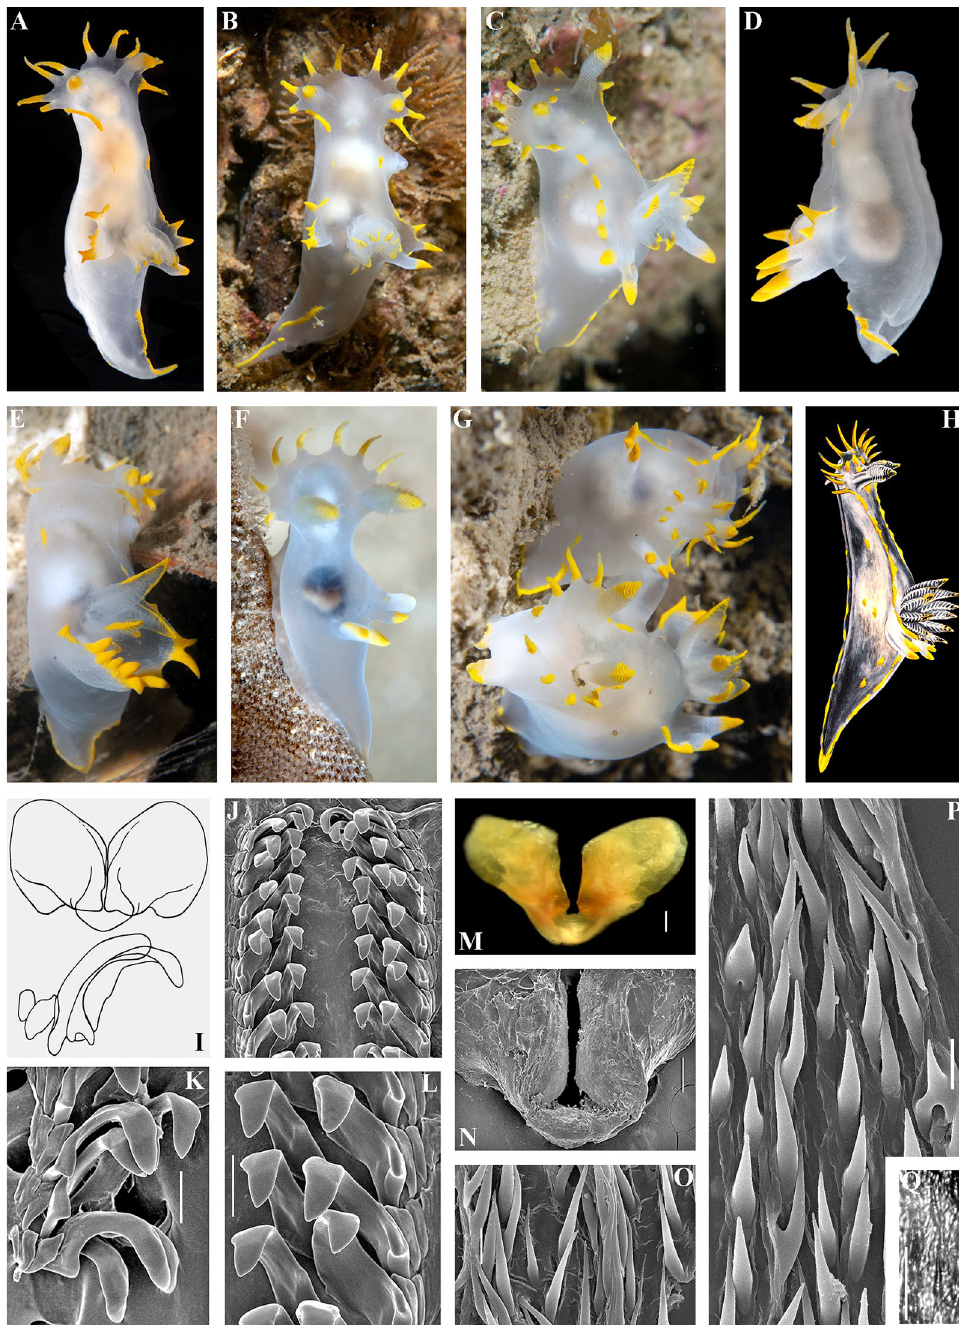
Figure 8. Polycera faeroensis Lemche, 1929 41 . External and internal morphology, light and scanning electron microscopy and comparison with data from Thompson and Brown 40 . ( A , B ) Specimen from United Kingdom, Belfast Lough, Northern Ireland, dorsal views, live (ZMMU Op-774). ( C ) Specimen from United Kingdom, Strangford Lough, Northern Ireland, dorsolateral view, live. ( D ) Another specimen from Strangford Lough, Northern Ireland, lateral view, live. ( E ) Specimen from the United Kingdom, Skomer Island, Pembrokeshire, dorsal view, live. ( F ) Juvenile specimen from the Strangford Lough, dorsal view, live. ( G ) Copulating specimens from Skomer Island, Pembrokeshire, Wales, dorsal views. ( H ) Specimen from United Kingdom, Isle of Man, depicted in Thompson and Brown ( 40 : pl 18, g). ( I ) Schemes of jaws (above) and radula teeth (below) of holotype from the Faeroe Islands. ( J ) Radula, SEM (ZMMU Op-774). ( K , L ) Same, details of radula. ( M ) Jaws, light microscopy (ZMMU Op-774). ( N ) Same, details, SEM. ( O , P ) Copulative spines, SEM (specimen from Belfast Lough). ( Q ) Same, light microscopy. Scale bars: j–l—100 μm, m, n—200 μm, o–q—10 μm. Photographs: Bernard Picton (a–g). Reproduction of figure from Thompson and Brown 40 with permission of Gregory Brown, original artist and copyright holder of the images. SEM micrographs and light microscopy photographs: Alexander